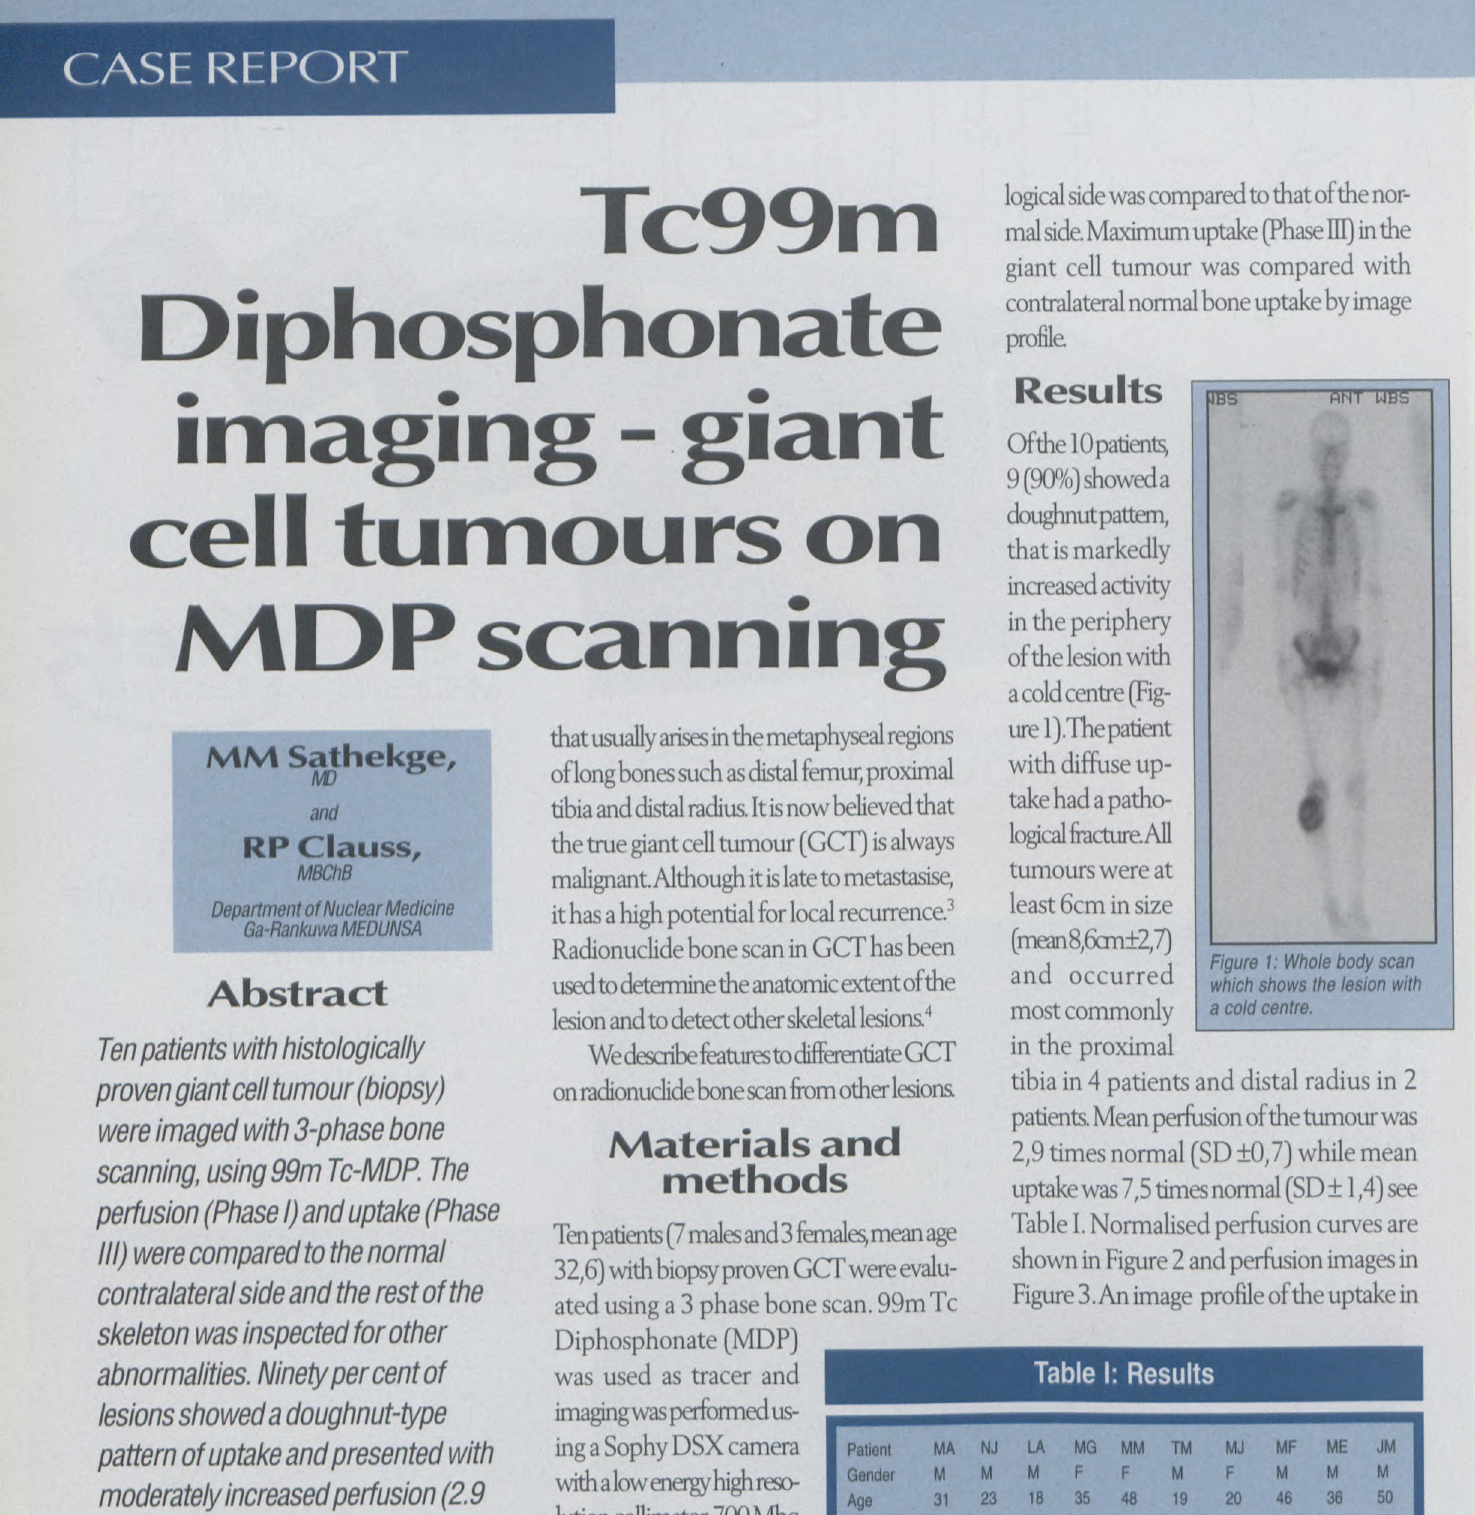
Figure 1: Whole body scan which shows the lesion with most commonly a cold centre. L.__ in the proximal tibia in 4 patients and distal radius in 2 patients. Mean perfusion of the tumour was 2,9 times normal (SO ±O,7) while mean uptake was 7,5 times normal (SO ± 1,4) see Table 1. Normalised perfusion curves are shown in Figure 2 and perfusion images in Figure 3.An image profile of the uptake